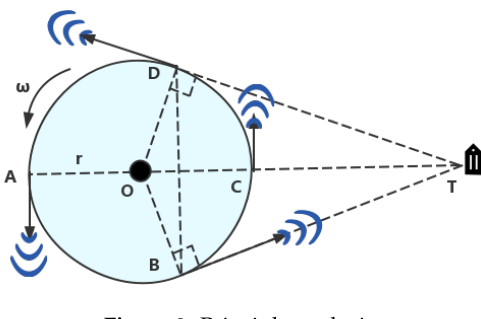
Figure 3. Principle analysis.